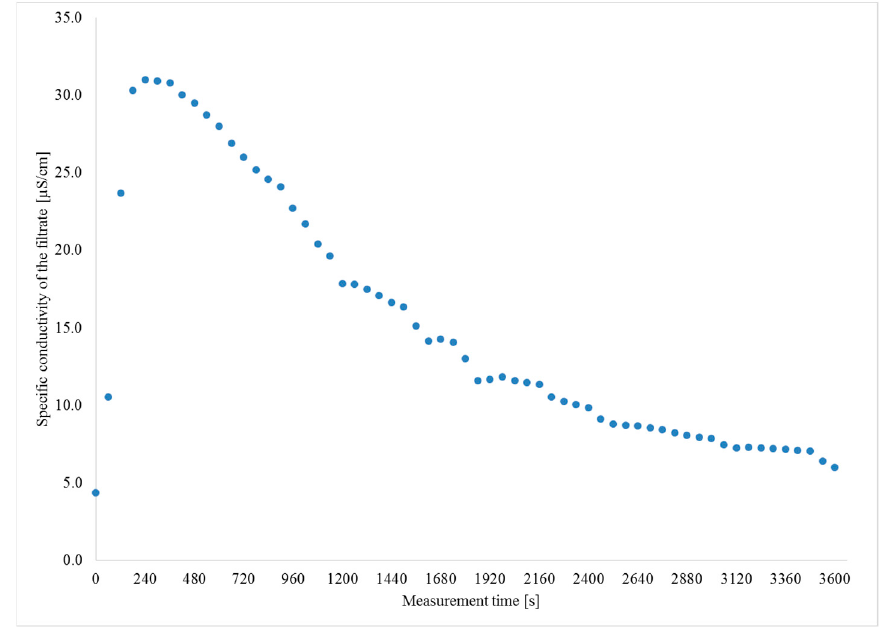
Figure 2. Specific conductivity of the filtrate.